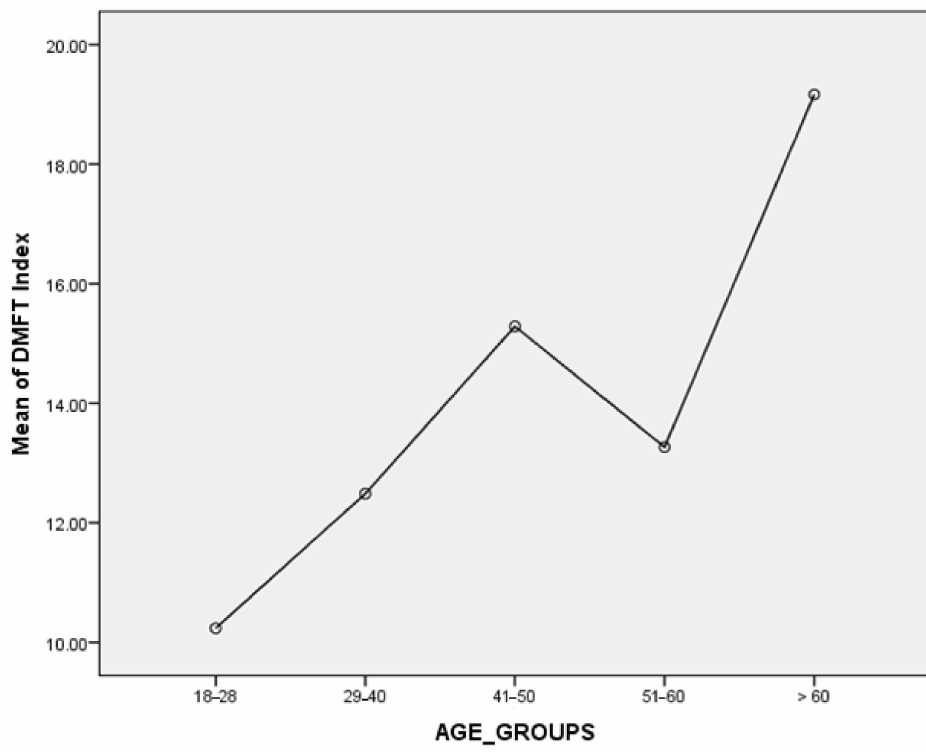
Figure 1. Association of mean of DMFT scores with respect to age